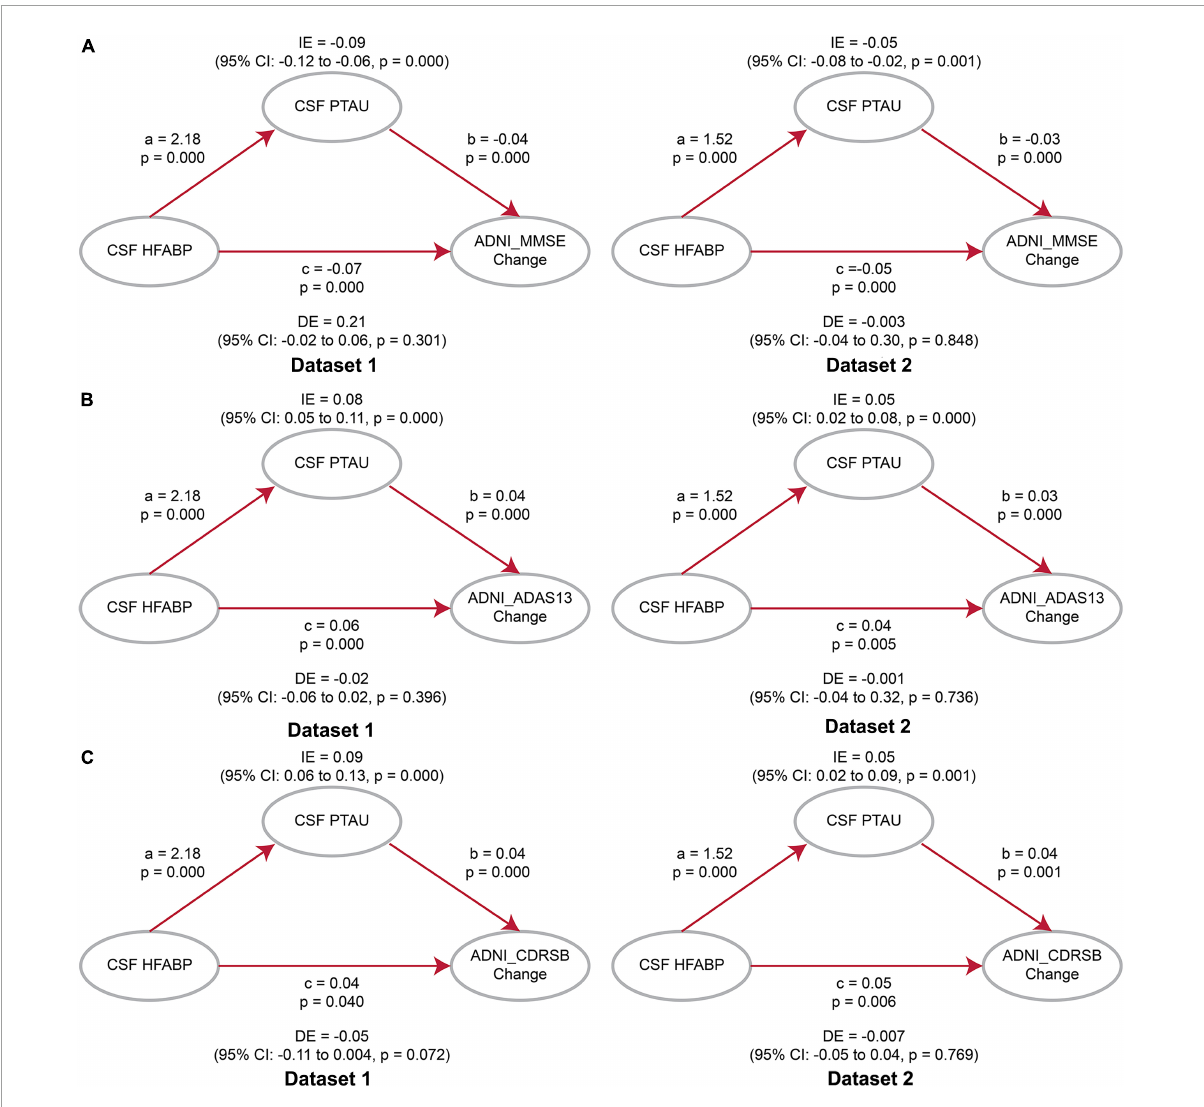
FIGURE4 Mediation analyses showed that the relationship between heart fatty acid-binding protein (HFABP) and longitudinal cognition change was mediated by tau pathology. (A) Global cognition measured by Mini-Mental State Examination (MMSE); (B) global cognition measured by ADAS13; (C) global cognition measured by Clinical Dementia Rating sum of boxes (CDRSB). MMSE, Mini-Mental State Examination; CDRSB, Clinical Dementia Rating sum of boxes; ADAS13, the cognitive section of Alzheimer’s Disease Assessment Scale; ABETA, Amyloid beta; P-tau, phosphorylated tau; IE, Indirect effects; DE, Direct